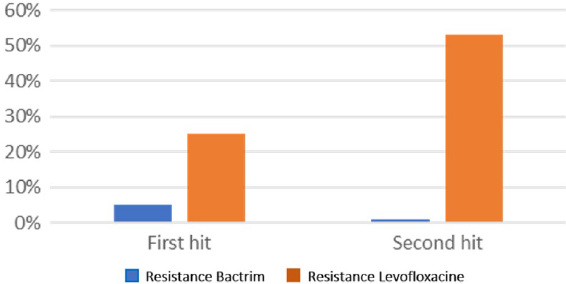
Figure 3. In Vitro resistance of S. maltophilia pathogen to antibiotics (Trimethoprim-sulfamethoxazole and Levofloxacine) during first and second hit.